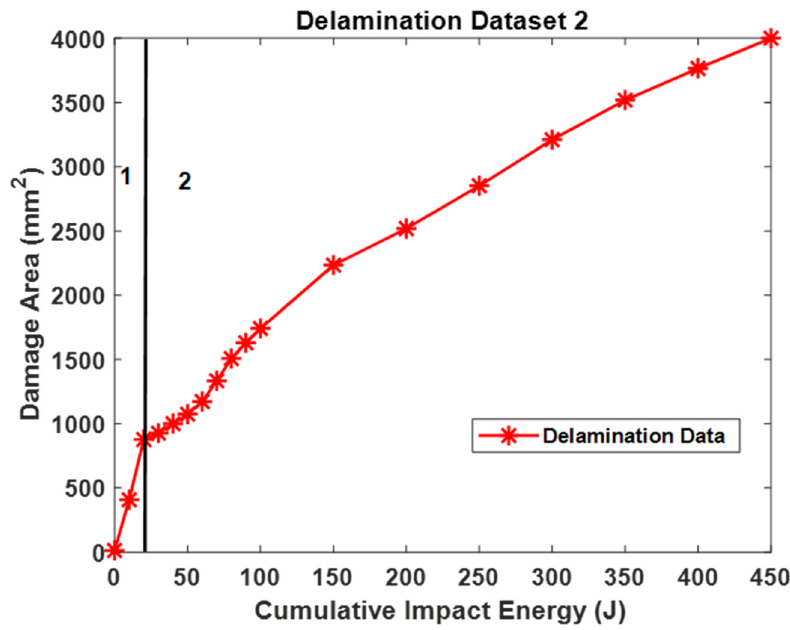
Figure 6. The damage growth area for sample S1 subjected to low-velocity impacts till the damage eventually led to fiber breakage.